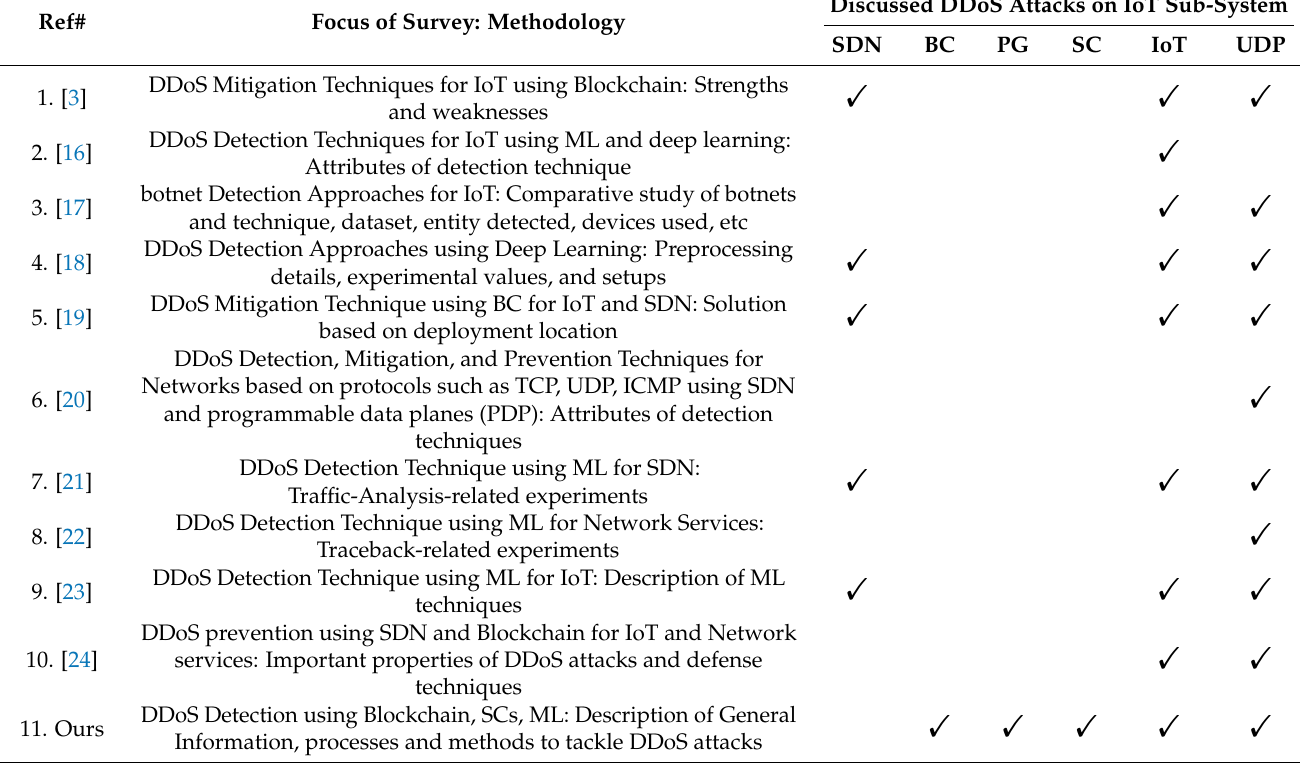
Table 2. Salient Features of Surveys, Including Ours, where SDN means software-defined networking,